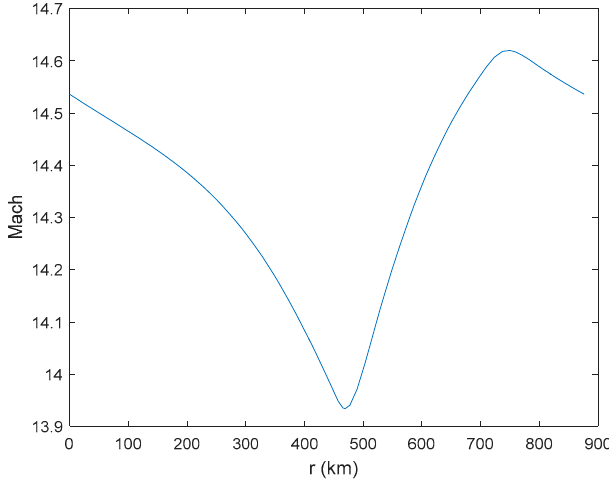
Appl. Sci. 2020 , 10 , x FOR PEER REVIEW Figure 2. Optimal Mach number at the initial altitude of 45 km. Figure 2. Optimal Mach number at the initial altitude of 45 km. Figure 2. Optimal Mach number at the initial altitude of 45 km.